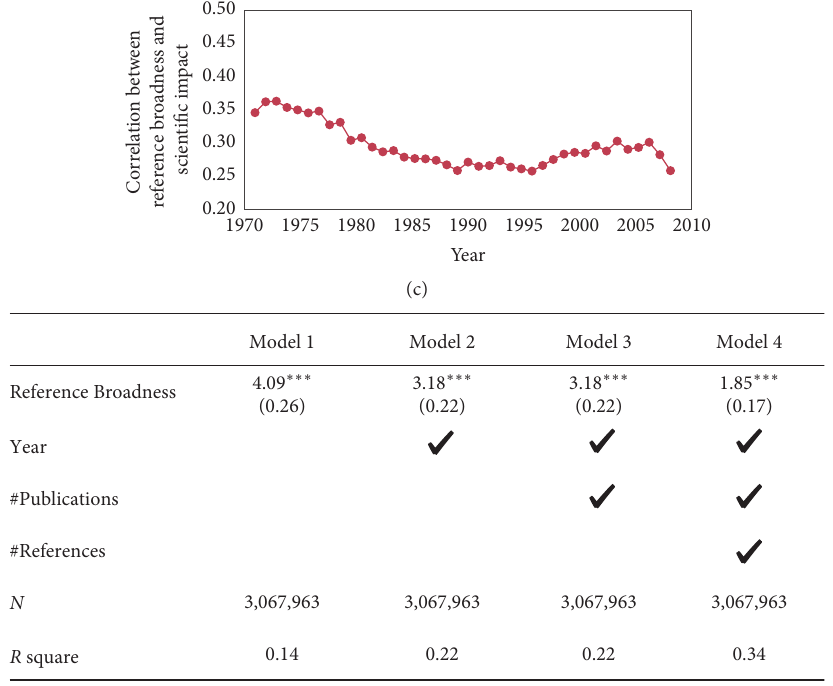
Figure 5: The association between field’s reference broadness and its scientific impact. The correlation between field reference broadness and its impact for 1995 (a) and 2005 (b). (c) The correlation as a function of time. (d) Linear regression results with dependent variable the field’s scientific impact and the focal independent variable as field’s reference broadness. Standard errors are clustered at the MAG level-0 field level. ∗∗∗ p < 0 . 001, ∗∗ p < 0 . 05, and ∗ p < 0 .